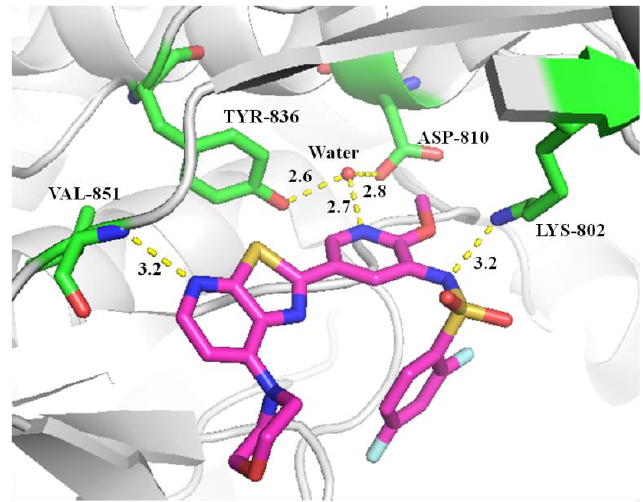
Figure 4. Predicted binding mode of 19a with PI3Kα .